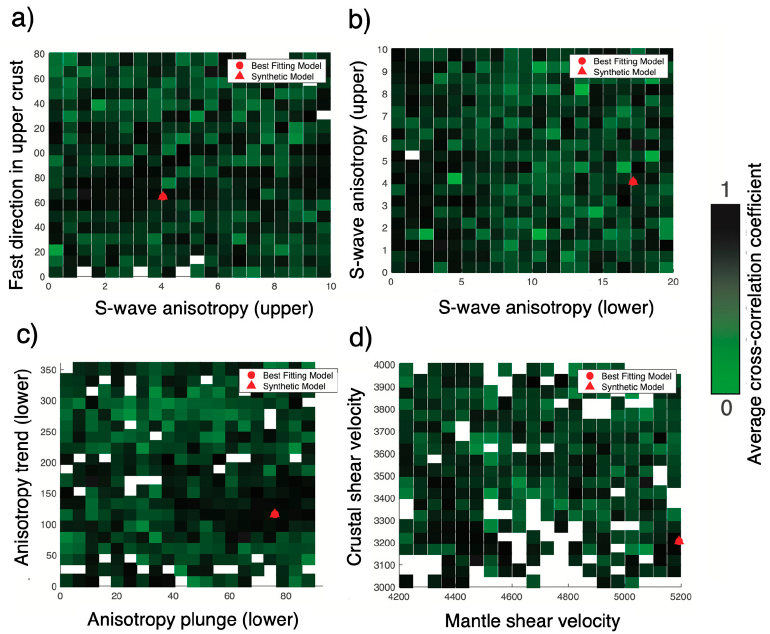
Figure 3. Results from the synthetic test of the Neighborhood Algorithm inversion. ( a ) Fast direction (azimuth) versus shear-wave anisotropy in the upper crust (%). ( b ) Shear-wave anisotropy in the upper crust (%) versus shear-wave anisotropy in the lower crust (%). ( c ) Trend (degree) versus plunge (degree) of lower crustal anisotropy. ( d ) Crustal versus mantle shear-wave velocity (m/s). Note that the agreement between the synthetic model and the best-fitting model is nearly indistinguishable in all cases.